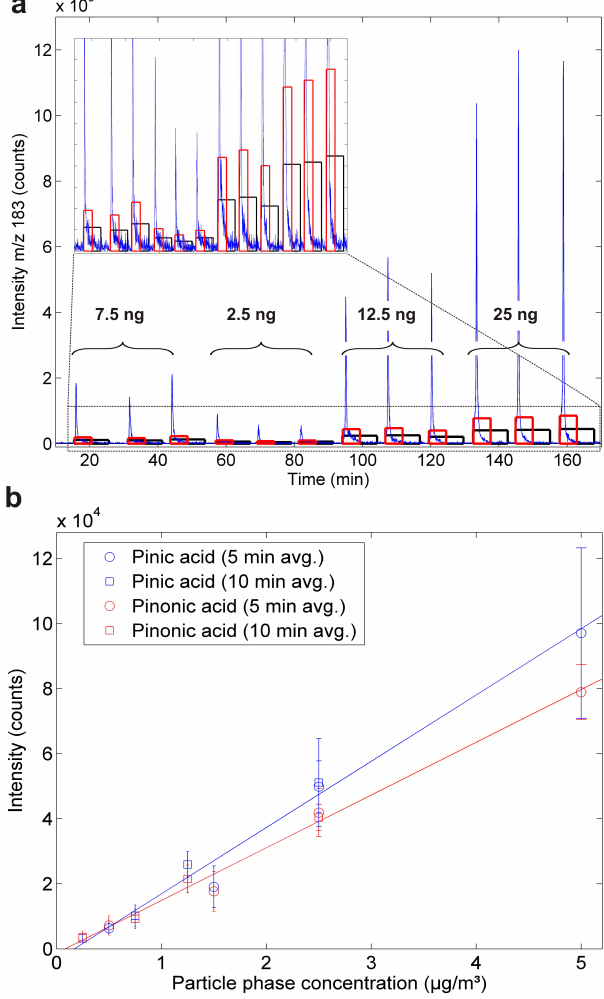
Fig. 3. (a) Mass trace of pinonic acid ( m/z 183) during calibration (blue), mean intensity for 5min (red) and 10min intervals (black). (b) Linear fit of calibration for pinonic acid ( m/z 183, red) and pinic acid ( m/z 185,